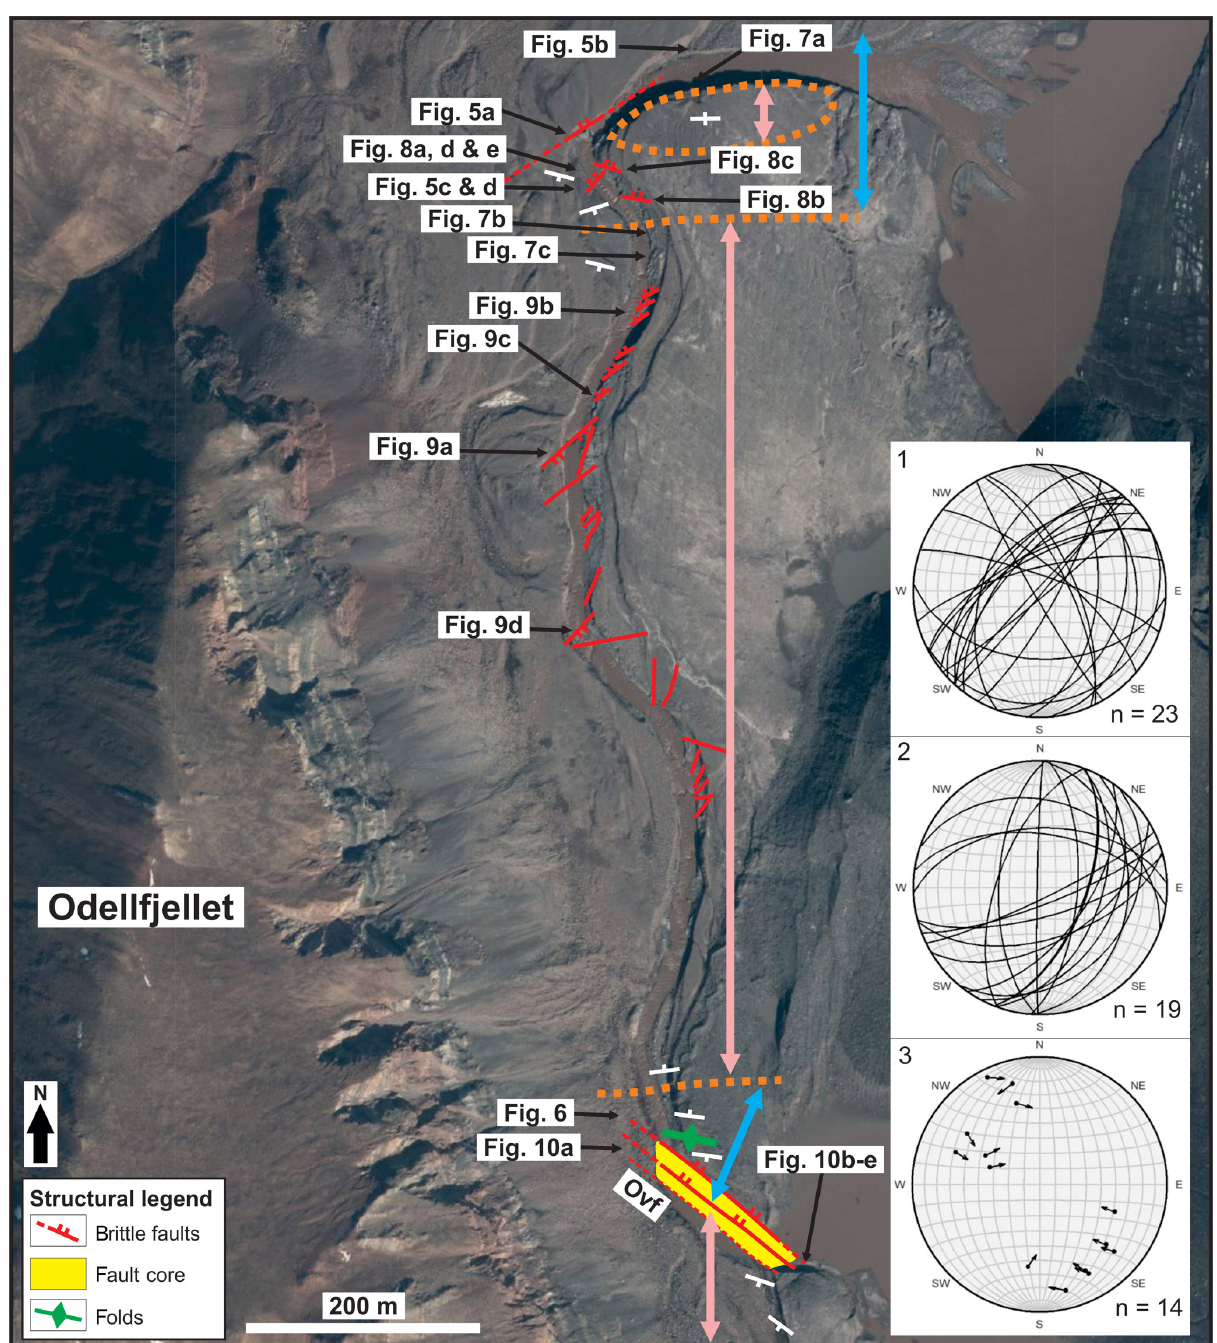
Figure 4. Satellite image from https://toposvalbard.npolar.no showing the study area in Odellfjellet. The studied outcrops are located along a riverbed and consist of sedimentary rocks of the Billefjorden Group (blue double arrows) and Hultberget Formation (pink double arrows) crosscut by brittle faults (e.g., the Overgangshytta fault – Ovf). The riverbed runs subparallel to mountain cliff outcrops made of sedimen- tary strata of the Hultberget, Ebbadalen, and Minkinfjellet formations (Odellfjellet). Dotted orange lines represent stratigraphic boundaries between the Billefjorden Group and Hultberget Formation. Bedding surface measurements are shown as white lines. The stereoplots show (1) great circle fracture surfaces within rocks of the Billefjorden Group and (2) Hultberget Formation and (3) poles and vectors of slickenside lineations along brittle faults crosscutting rocks of the Billefjorden Group and Hultberget Formation. Location is shown by a red frame in Fig.